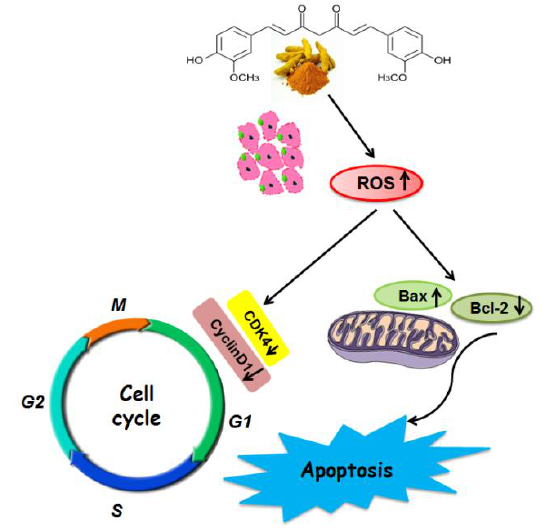
Figure 8. Schematic diagram shows the mechanisms underlying the inhibition of SKBR3 cells by curcumin and Cur-SLNs. curcumin and